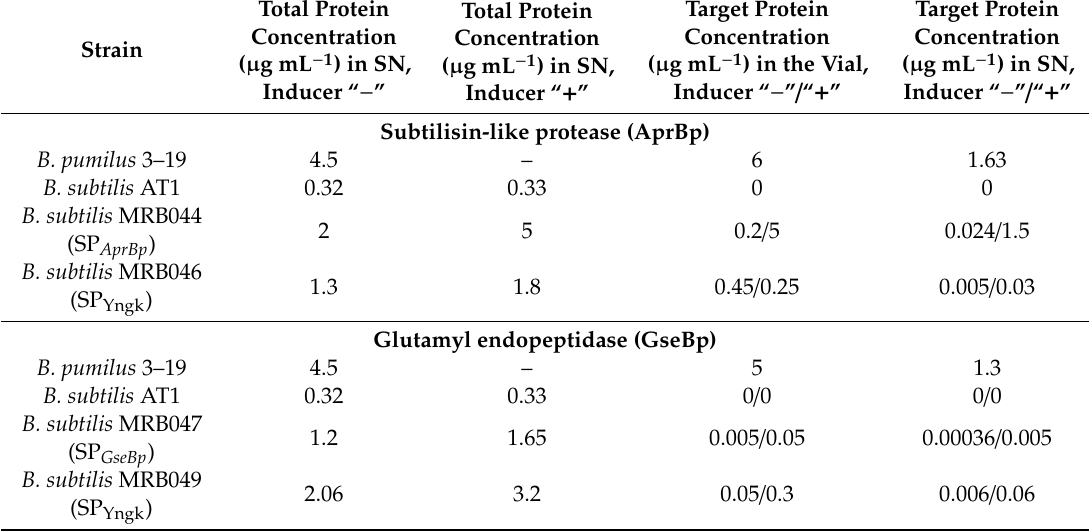
Table 2. Quantification of serine proteases AprBp and GseBp in the optimized LIKE expression system by MRM analysis. SN—supernatant; bacitracin is the inducer (50 µ g mL − 1 ); “ − ”—without addition of the inducer; “ + ”—after addition of the inducer. Strains B. pumilus 3–19 and B. subtilis AT1 were grown without the inducer